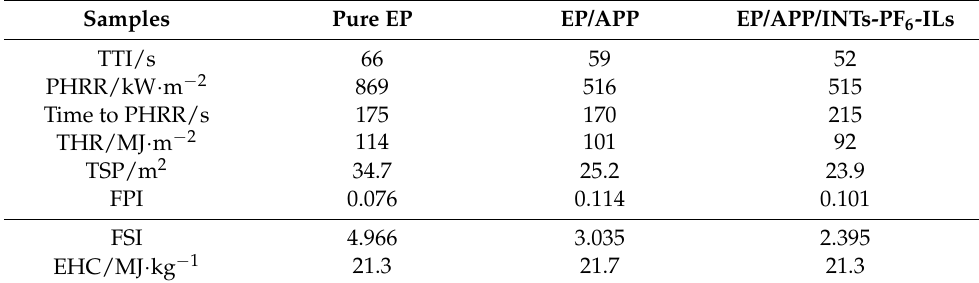
Table 4. The characteristic data tested by the cone